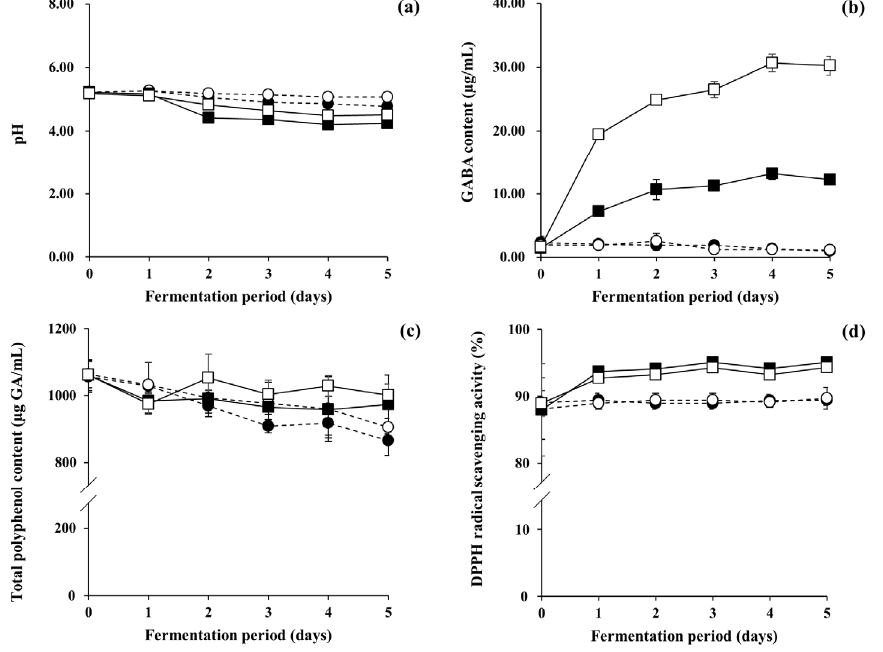
Figure 5. Changes in ( a ) pH, ( b ) GABA content, ( c ) total polyphenol content, and ( d ) DPPH radical scavenging activity of LFG under optimal fermentation conditions. ● : NN group (non-inoculated green tea with no supplementation), ○ : NS group (non-inoculated green tea with supplementation), ■ : IN group (green tea fermented with L. brevis 79 strain with no supplementation), □ : IS group (green tea fermented with L. brevis 79 strain with supplementation; optimal fermentation conditions). The results obtained from non-inoculated green tea were plotted with a dotted line. Supplementation consisted of 1% fermentation alcohol, 6% glucose, and 1% MSG. Error bars indicate standard deviations determined from triplicate